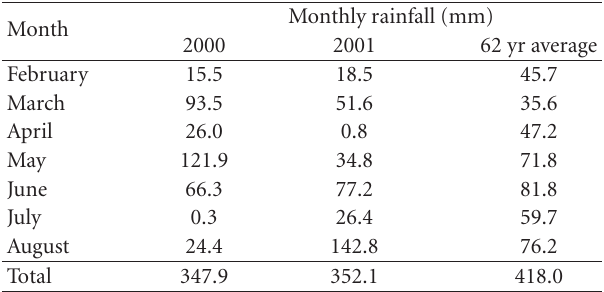
Table 1: Monthly rainfall in the Corpus Christi area in 2000 and